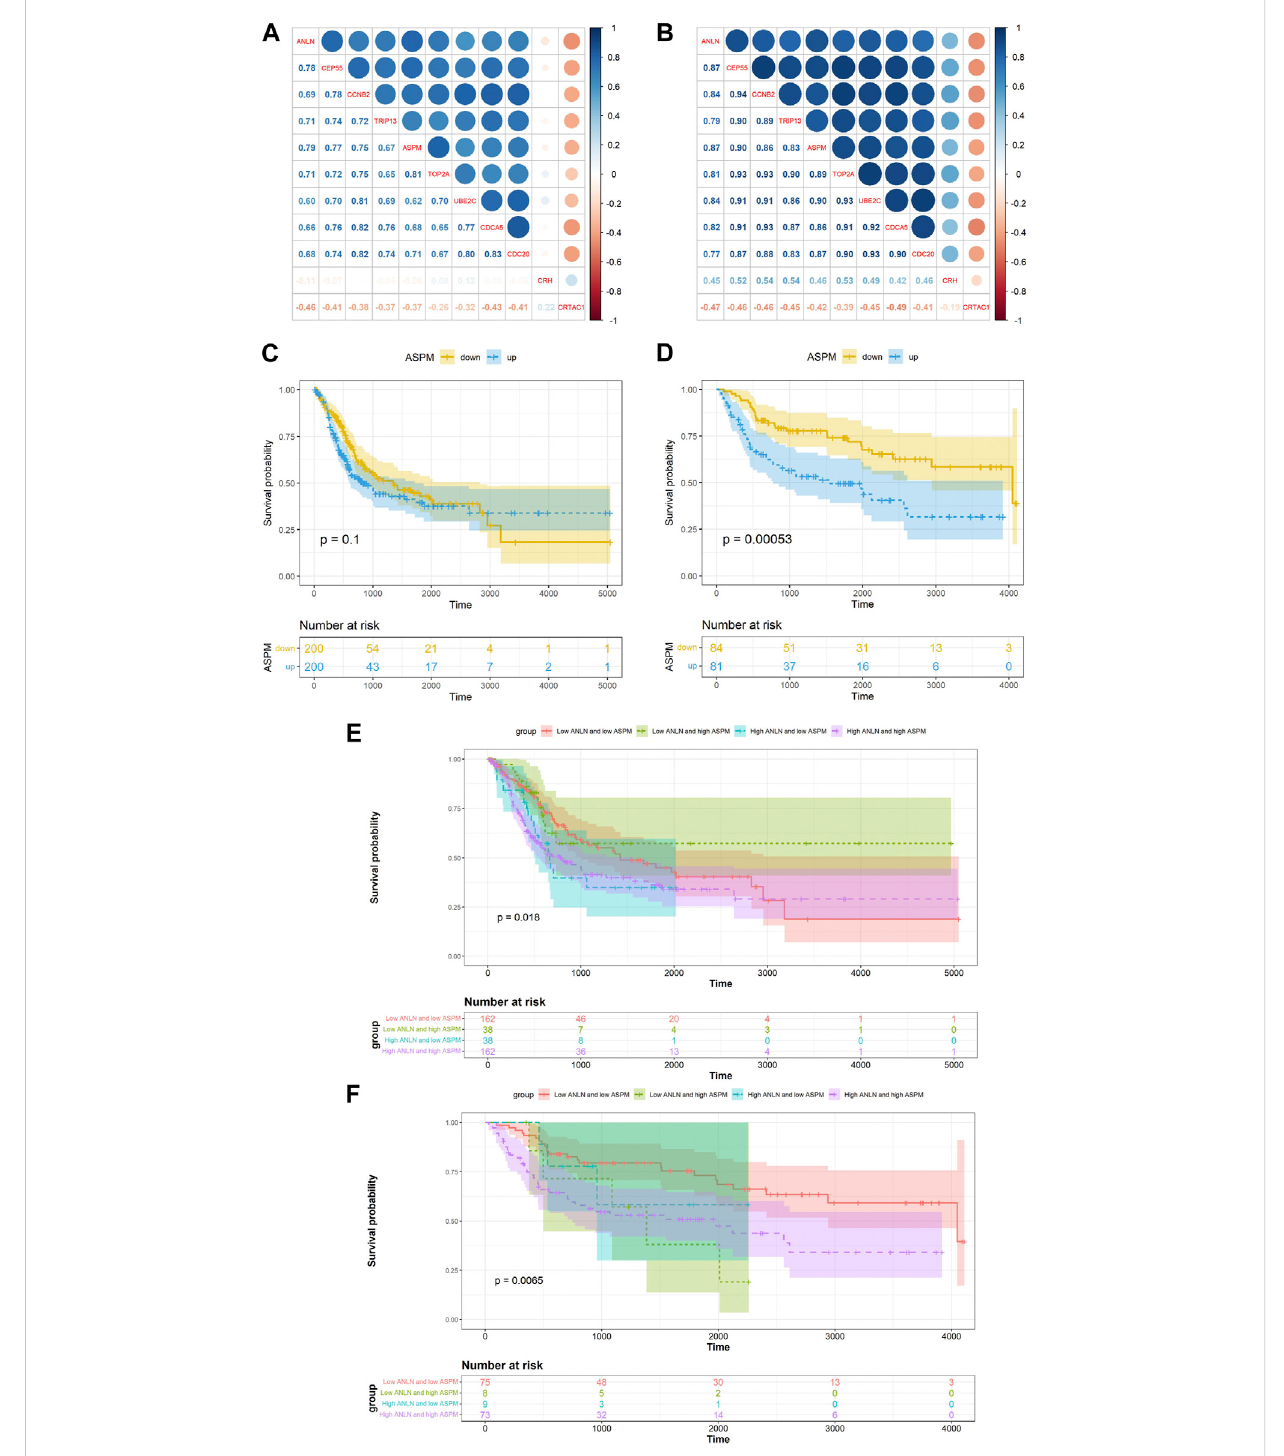
FIGURE 4 Correlation between ANLN related DEGs and ANLN based on TCGA-BLCA (A) and GSE13507 (B) . K-M survival curves of ASPM in bladder cancer based on TCGA-BLCA (C) and GSE13507 (D) . The K-M survival curves of ANLN and ASPM with different expression levels in bladder cancer based on TCGA-BLCA (E) and GSE13507 (F)